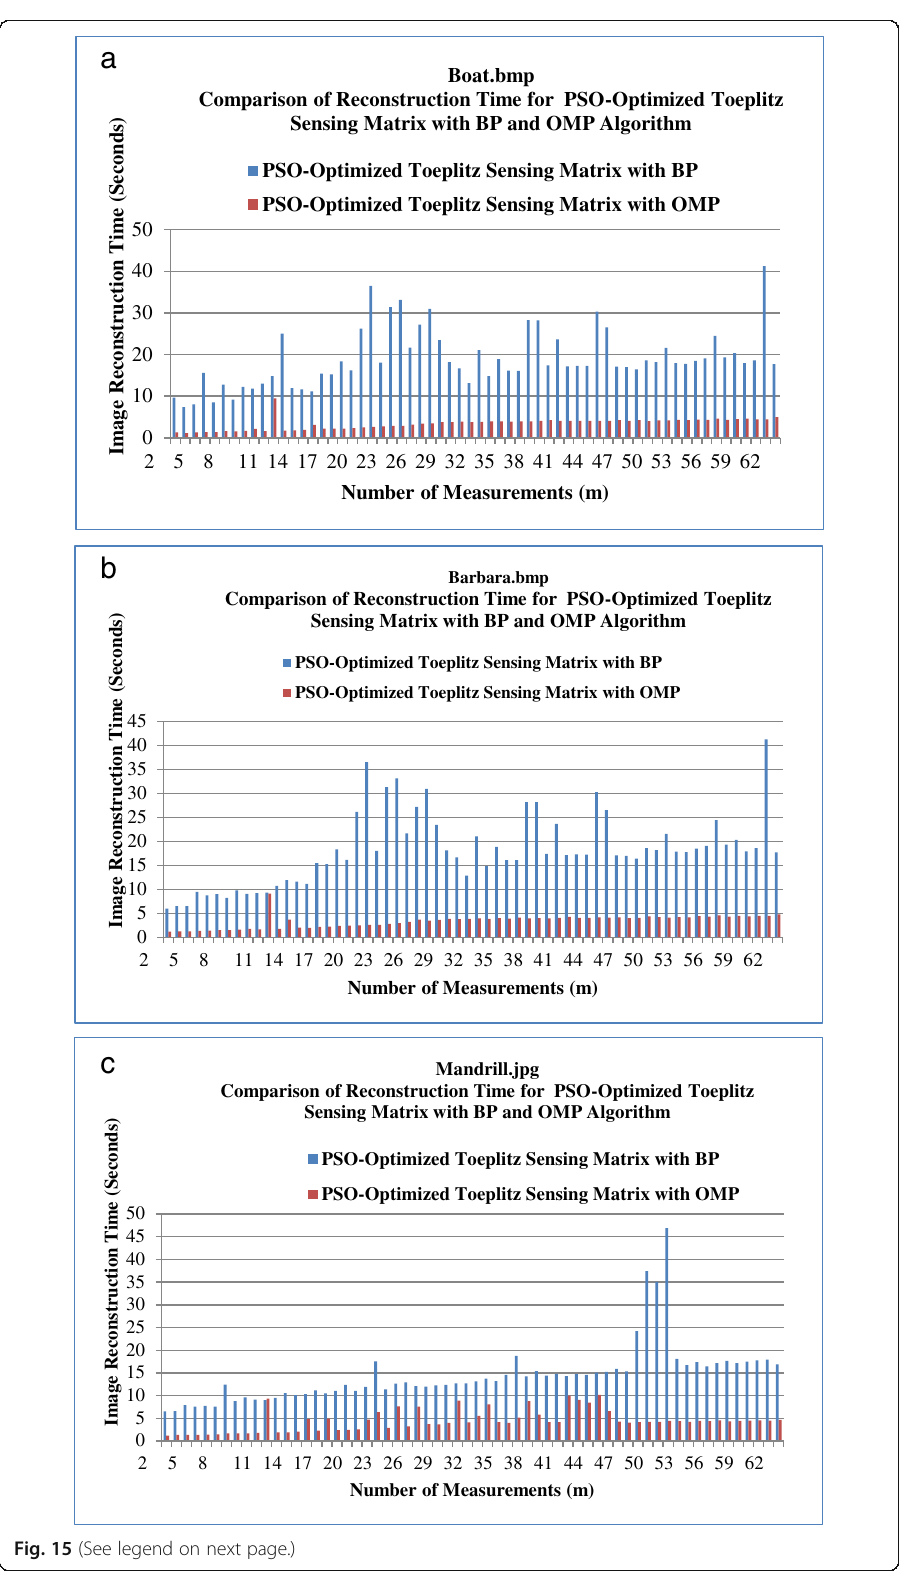
PSO-Optimized Toeplitz Sensing Matrix with BP